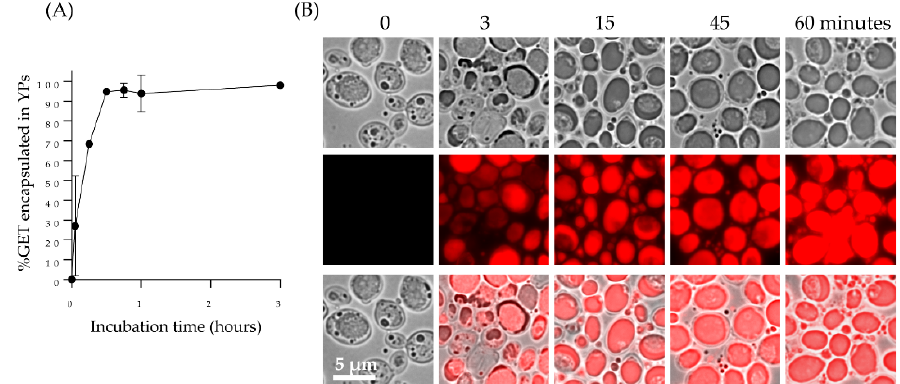
Figure 2. ( A ) Kinetics of 2:1:2 GET loading in YPs quantified by HPLC of samples prepared at GET:YP ratio of 1.1:1 in a homogenized YP suspension (final concentration of 150 g YP/L, 16.5% GET), and ( B ) microscopy images of Nile red-stained YP control (t = 0) and YPs loaded with GET collected at different timepoints showing Nile red-stained terpenes encapsulated in YPs.